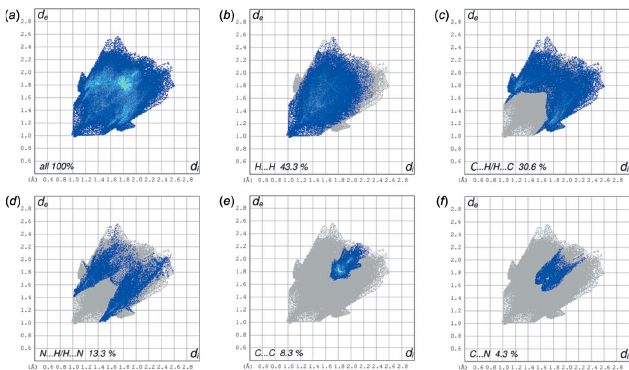
Figure 7 The full two-dimensional fingerprint plot for Form II, and fingerprint plots delineated into H (cid:2)(cid:2)(cid:2) H, C (cid:2)(cid:2)(cid:2) H/H (cid:2)(cid:2)(cid:2) C, N (cid:2)(cid:2)(cid:2) H/H (cid:2)(cid:2)(cid:2) N, C (cid:2)(cid:2)(cid:2) C and C (cid:2)(cid:2)(cid:2) N